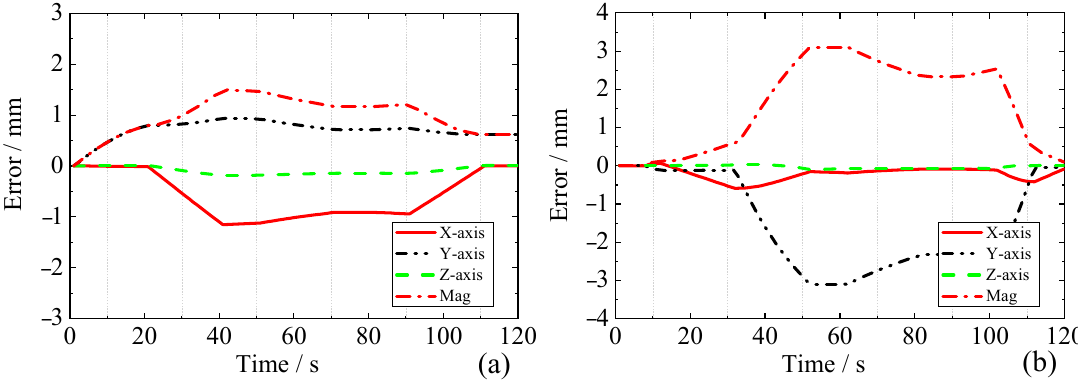
Figure 10. HKM end position error during the left outboard ( a ) and inboard ( b ) BB lifting.